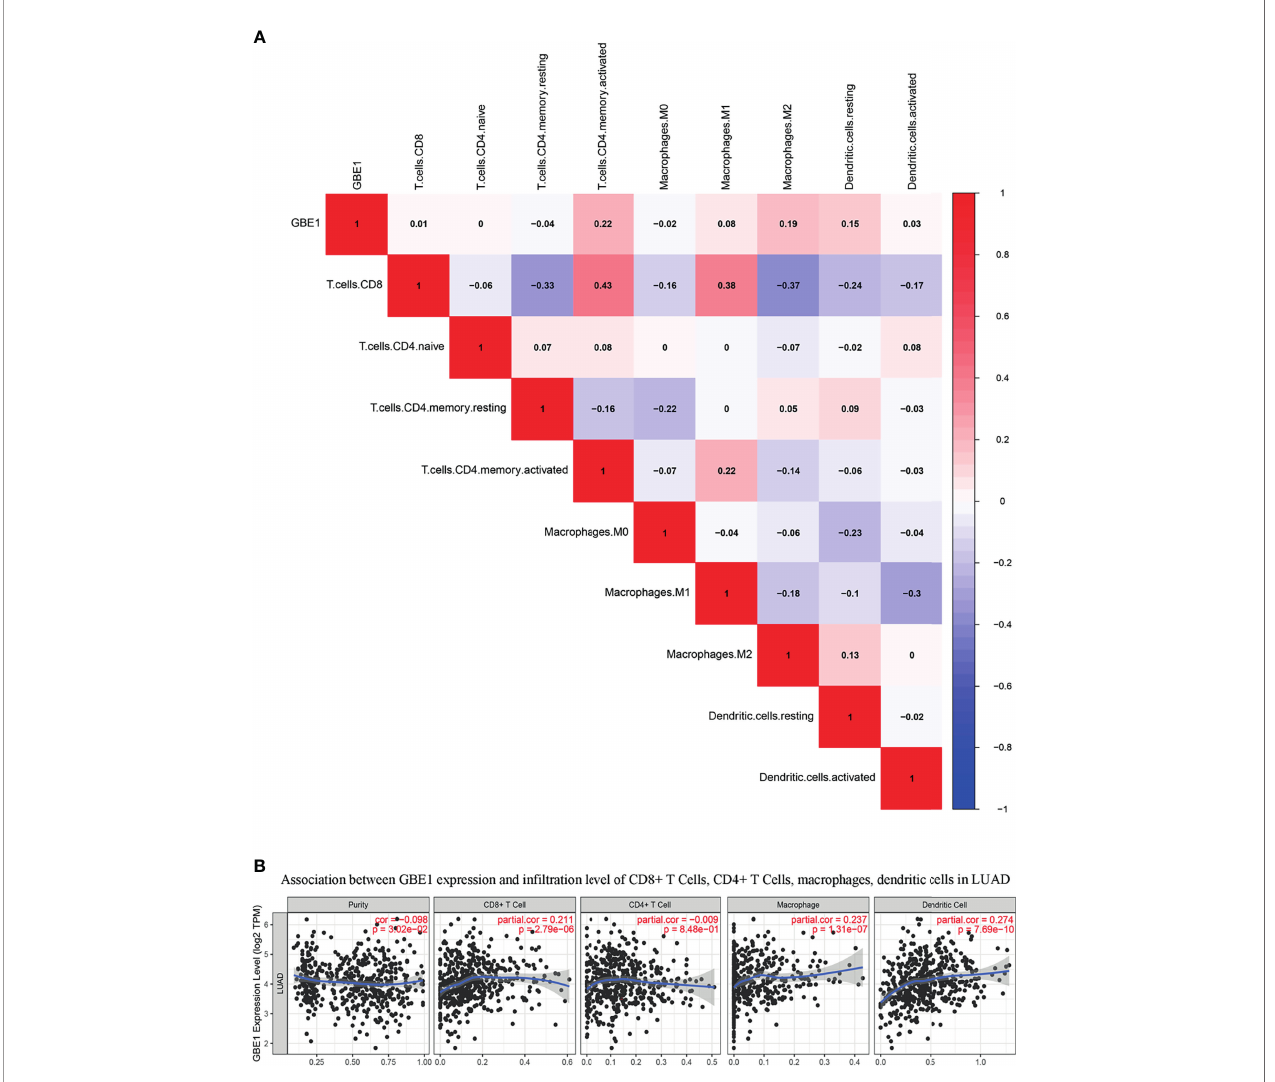
FIGURE 5 | (A) The relationship between GBE1 expression and immune-in fi ltrating cells by utilizing CIBERSORT algorithm: GBE1 expression was positively correlated with M2 macrophage in fi ltration of M2 macrophages, CD4 + memory-activated T cells, and resting dendritic cells. (B) The relationship between GBE1 expression and immune-in fi ltrating cells by utilizing the TIMER database: GBE1 expression was positively correlated with macrophage in fi ltration, CD8 + T-cell in fi ltration, and dendritic cell in fi